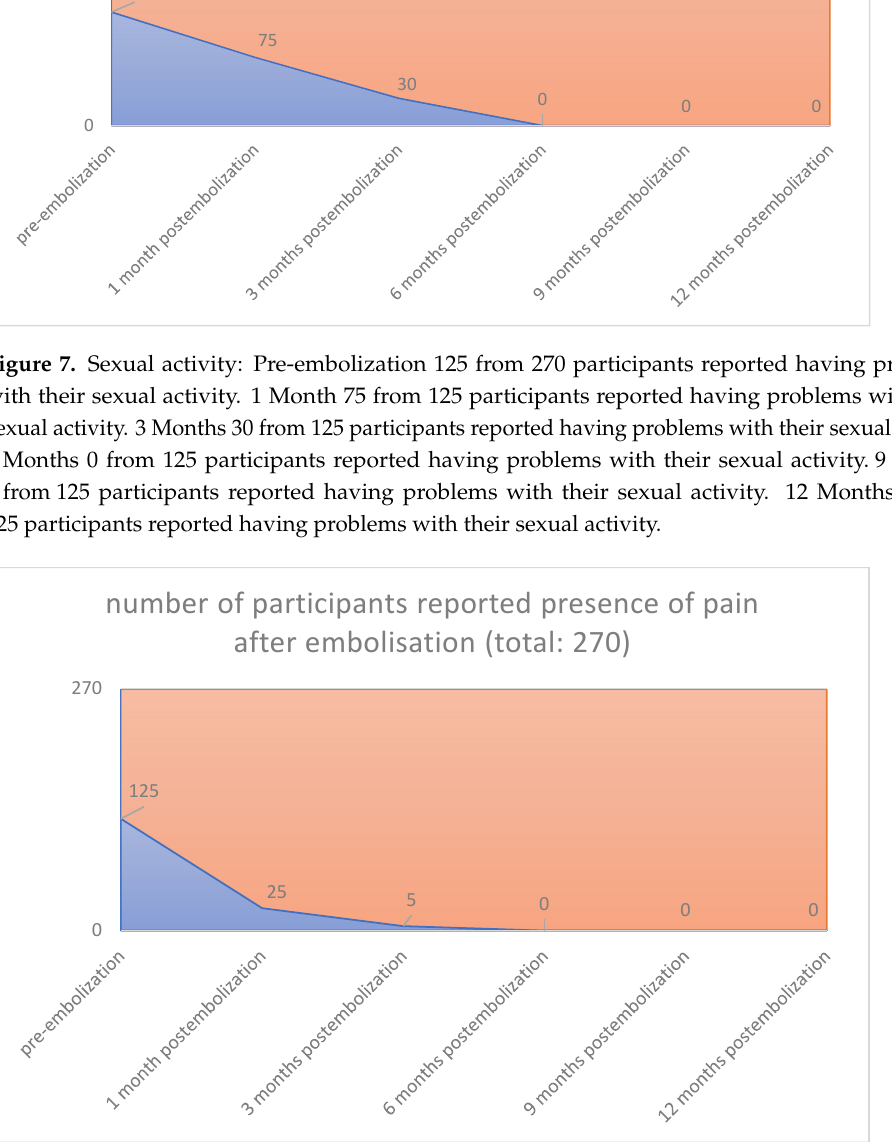
Figure 8. Pain, infection:. Pre-embolization 125 from 270 participants reported presence of pain . 1 Month 25 from 125 participants reported presence of pain, infection. 3 Months 5 from 125 par-ticipants reported presence of pain. 6 Months 0 from 125 participants reported presence of pain . 9